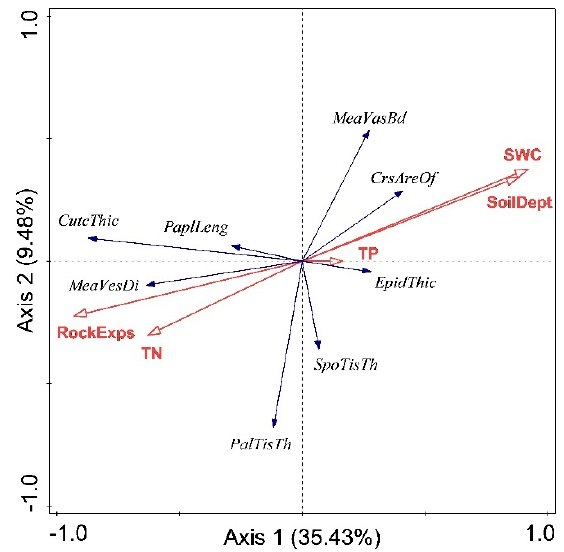
Figure 5. Redundancy analysis (RDA) of relationships among leaf anatomical traits and edaphic factors for Phyllostachys glauca in the limestone mountain. CutcThic , cuticle thickness; PaplLeng , pa- pillae length; MeavasBd , mean vascular bundle diameter; CrsAreOf , cross-sectional area of bulliform cell; EpidThic , epidermis thickness; SpoTisTh , spongy tissue thickness; PalTisTh , palisade tissue thick- ness; MeaVesDi , mean vessel diameter; SWC, soil water content; SoilDept, soil depth; TP, soil total phosphorus; TN, soil total nitrogen; and RockExps, rock exposure. Blue lines represent leaf anatom- ical traits, and red lines represent edaphic factors.